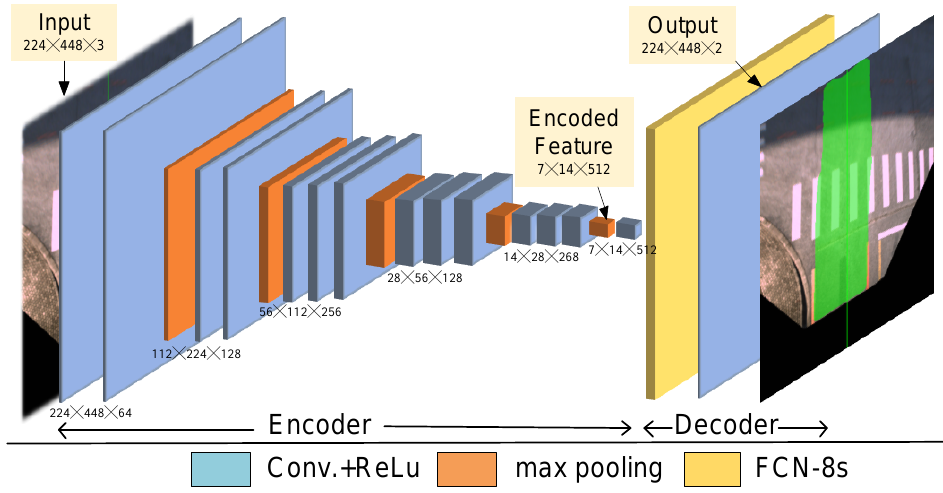
Figure 5. Segmentation model based on FCN-VGG16 [28].